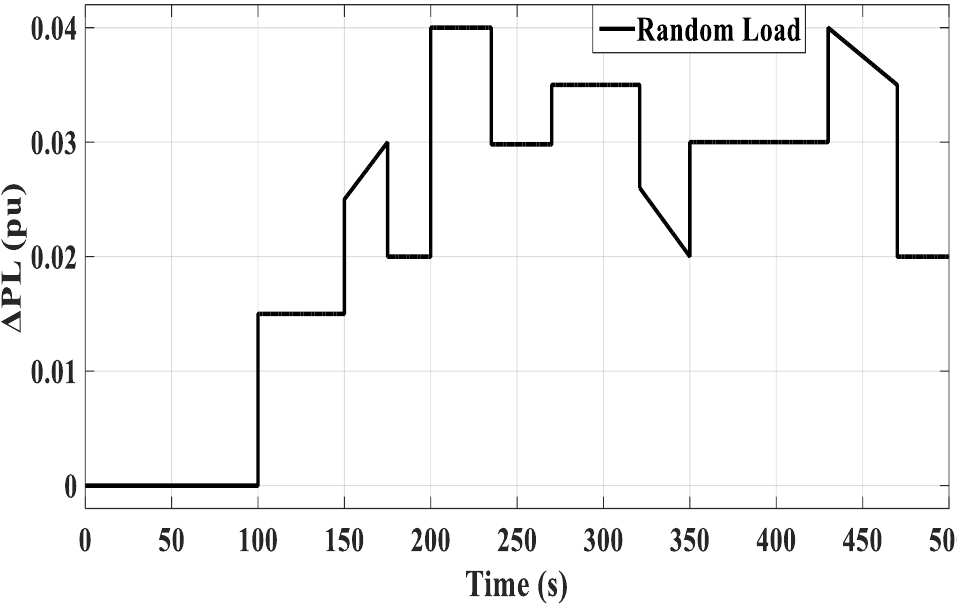
Figure 18. The form of applied random load variation.